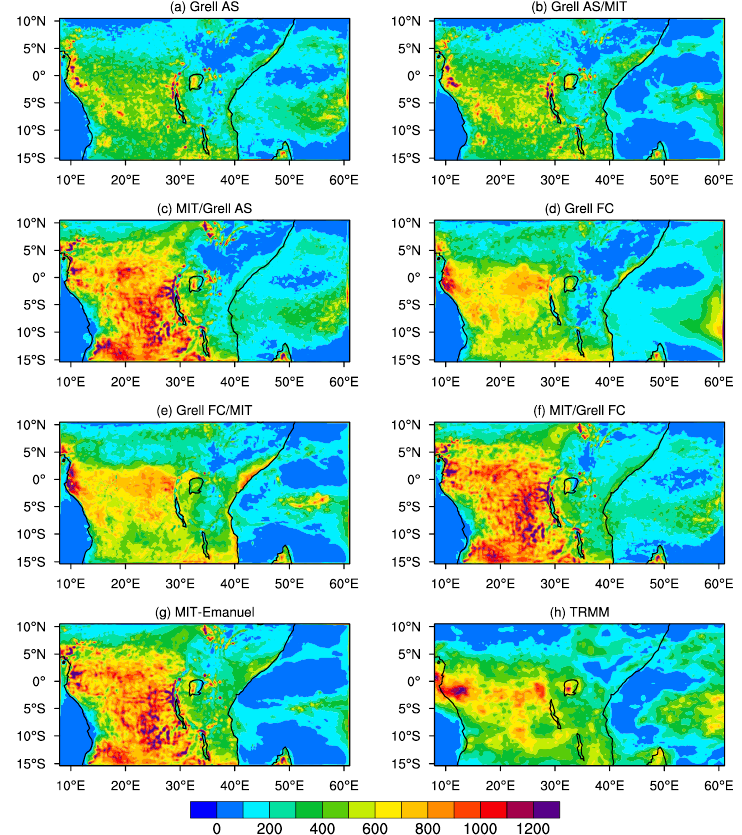
Figure 2. Precipitation distribution (mm) using different cumulus parameterizations: ( a ) Grell AS; ( b ) Grell AS over land and MIT over ocean; ( c ) MIT over land and Grell AS over ocean; ( d ) Grell FC; ( e ) Grell FC over land and MIT over ocean, ( f ) MIT over land and Grell FC over ocean, ( g ) MIT; and ( h ) Tropical Rainfall Measuring Mission (TRMM) during the Short Rains in